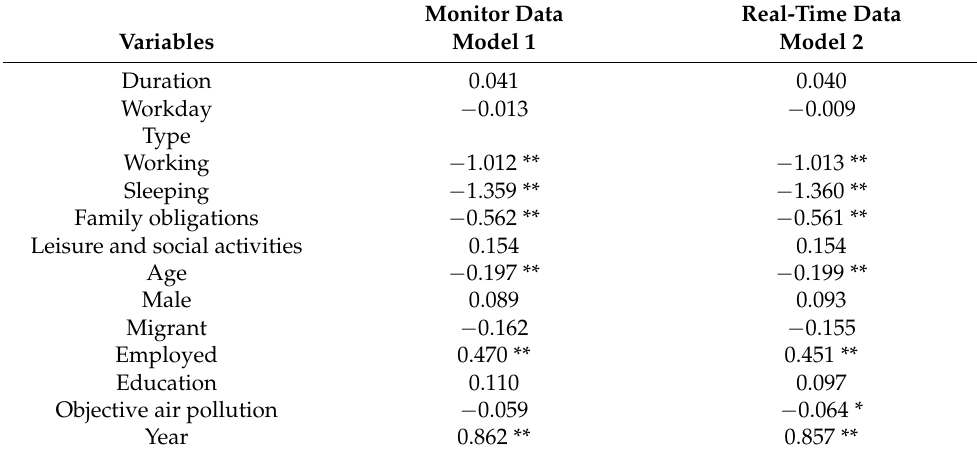
Table 2. Estimated coefficients of logistics models using monitor and real-time data.